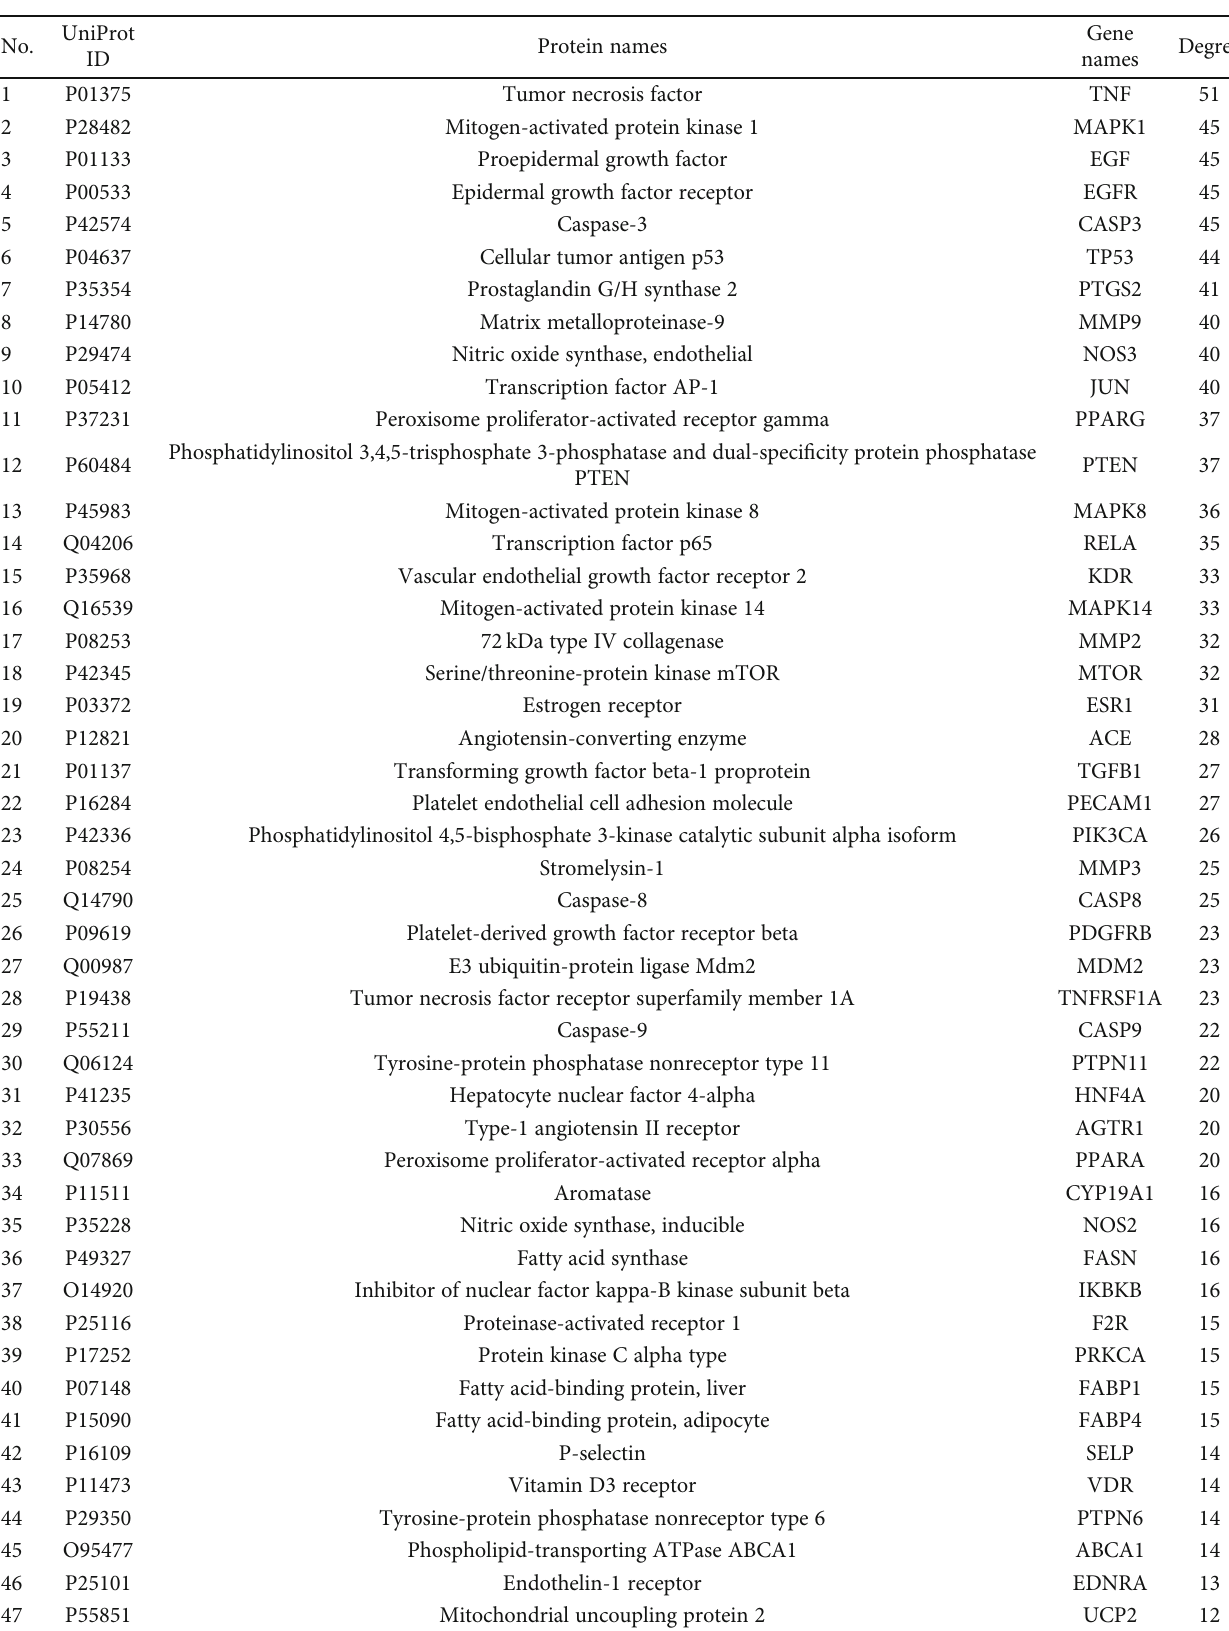
Table 2: Information of putative targets and topological